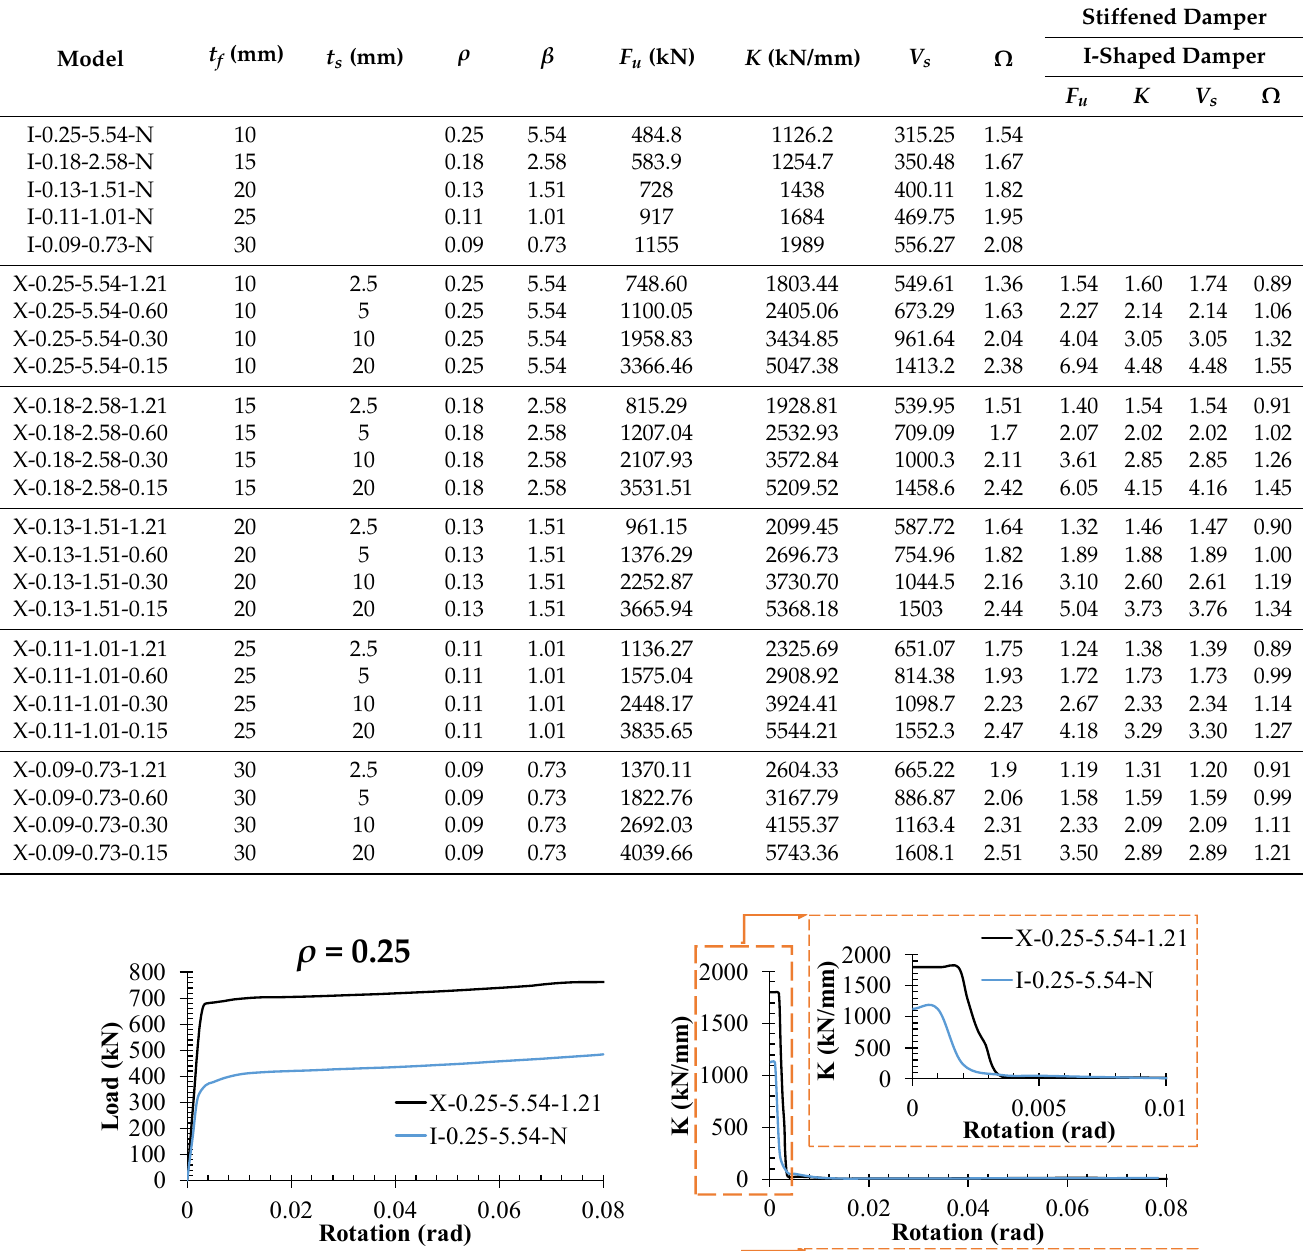
Table 2. Comparing results of damper with and without stiffeners.